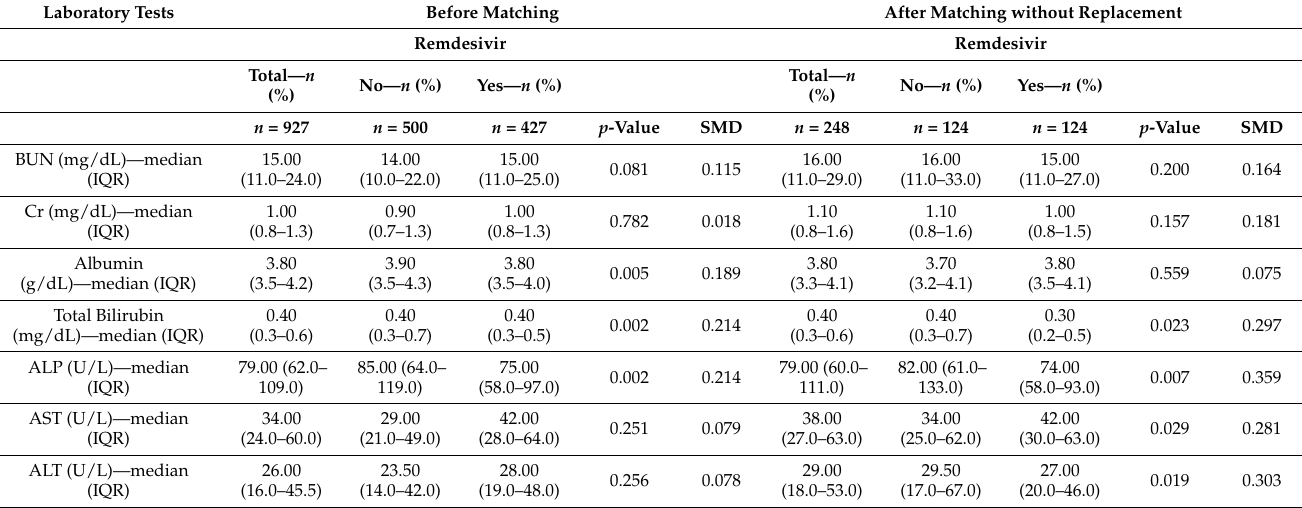
Table 2. Laboratory tests on